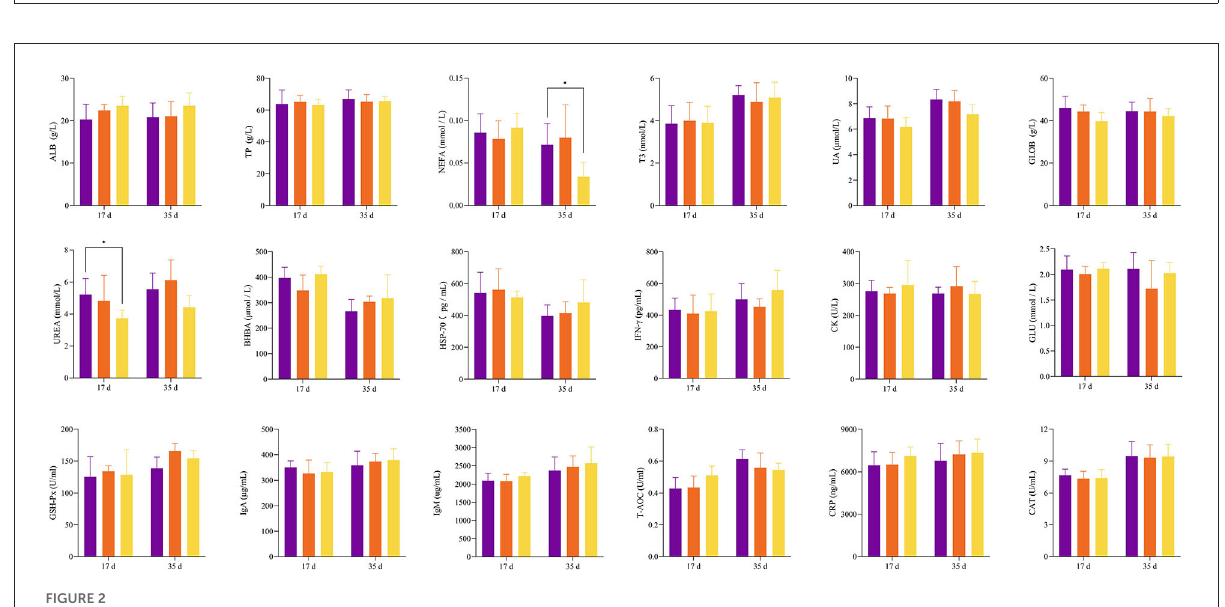
FIGURE2 Effect of FPPR on the serum indicators of black